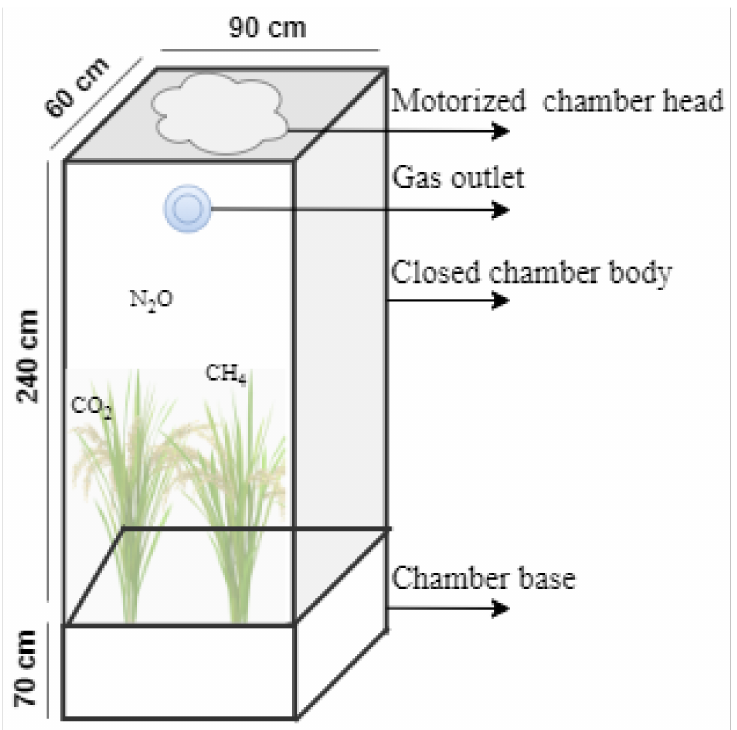
Figure 4. Proposed gas chamber